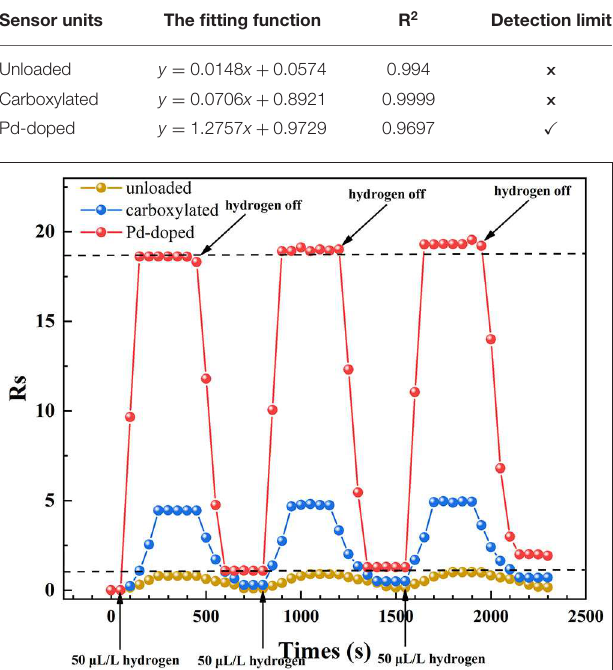
FIGURE 9 | The gas response and recovery time characteristics of three different SWCNTs-based gas